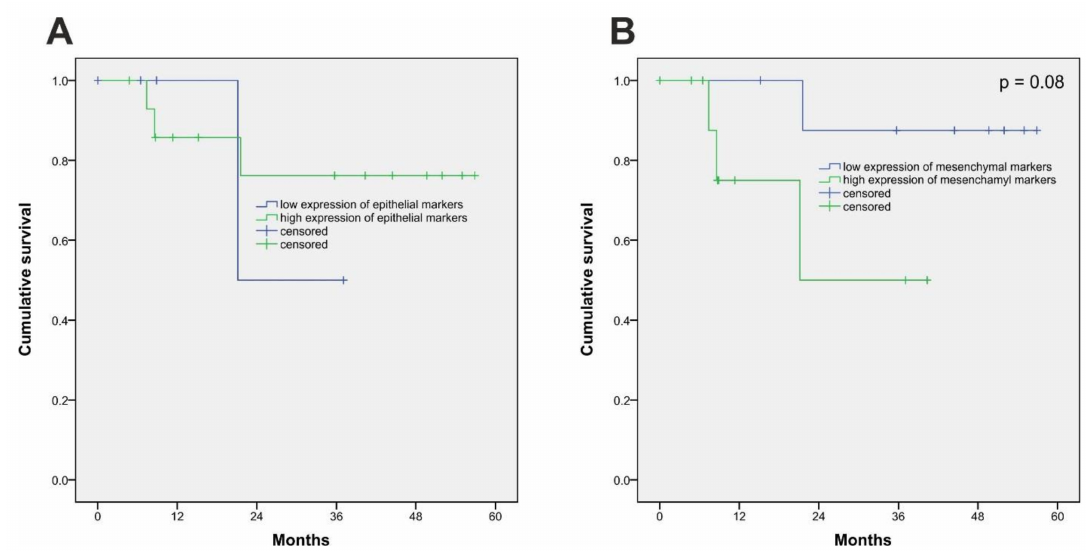
Figure 7. Selective survival analysis using epithelial ( A ) and mesenchymal ( B ) markers. Selection of epithelial and mesenchymal markers as well as the respective cut-o ff values to determine high / low cases was done based on K-means cluster analysis (Table 3). Selected epithelial markers